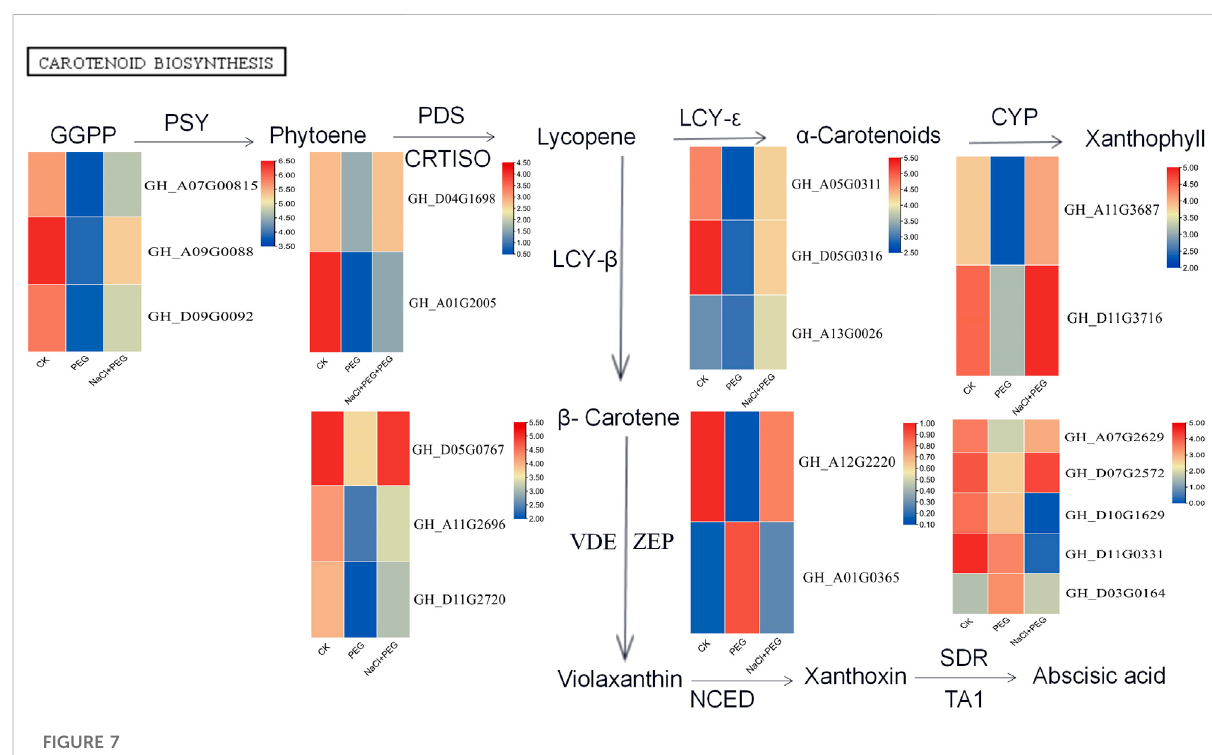
FIGURE 7 Changes of carotenoid pathway gene expression pro fi les after NaCl